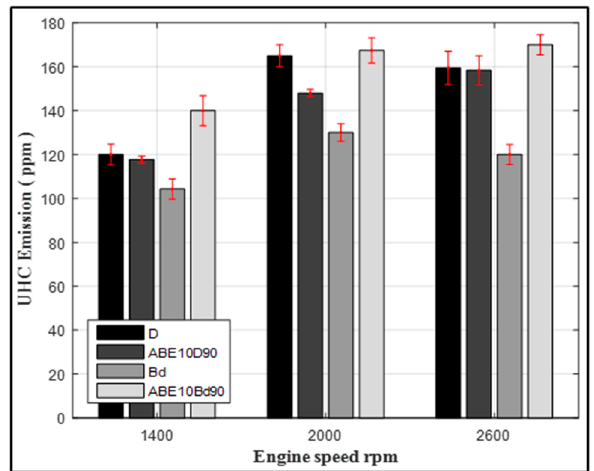
Figure 12. Unburnt hydrocarbon (UHC) emissions of test fuels.